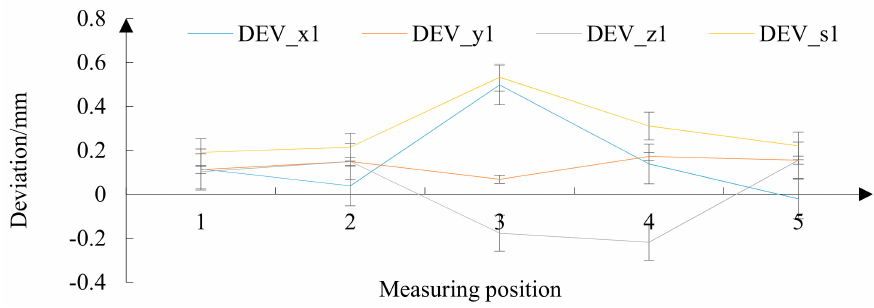
Figure 15. Relative deviation under traditional algorithm.